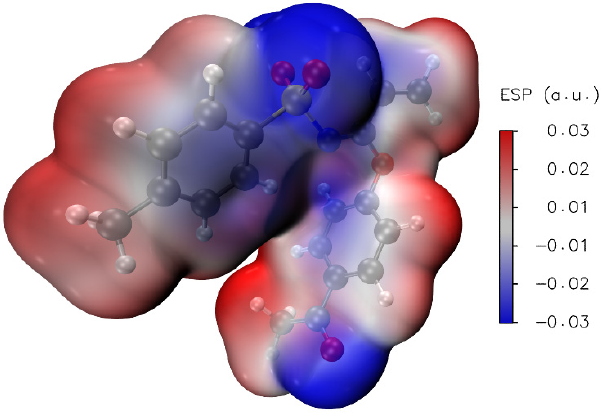
Figure 12. ESP (iso-surface 0.001 a.u.) for 3 calculated at PBE1PBE/cc-pVDZ level of theory.